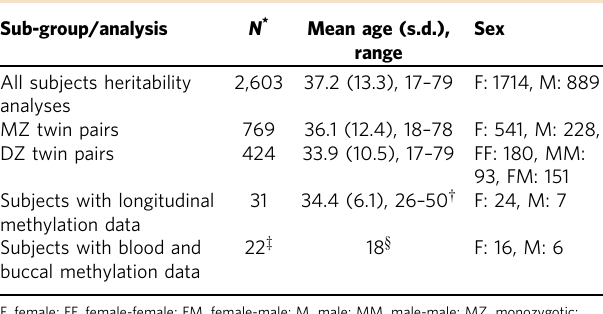
Table 1 | Characteristics of the